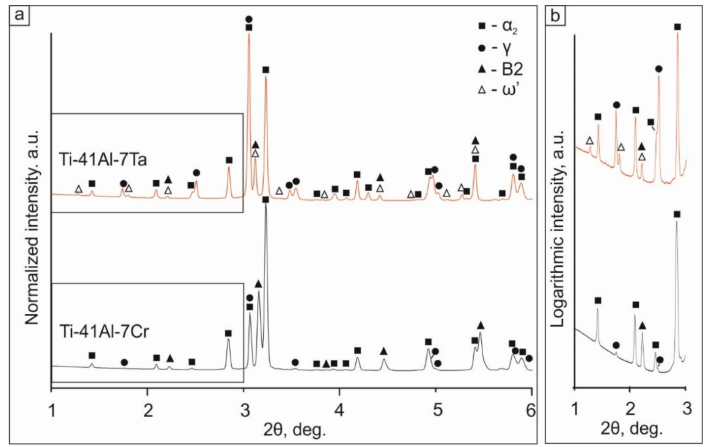
Figure 2. XRD patterns obtained from the samples ( a ). The same XRD patterns, but in the range from 1 to 3 ◦ plotted as logarithmic intensity over 2 θ ( b